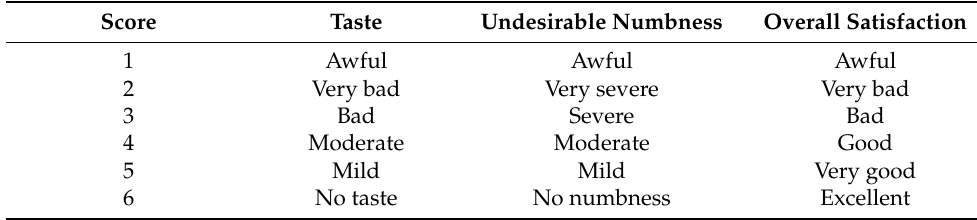
Table 1. The verbal rating scale and its descriptions for the following variables: taste, undesirable numbness, and overall satisfaction, where the participants rate their